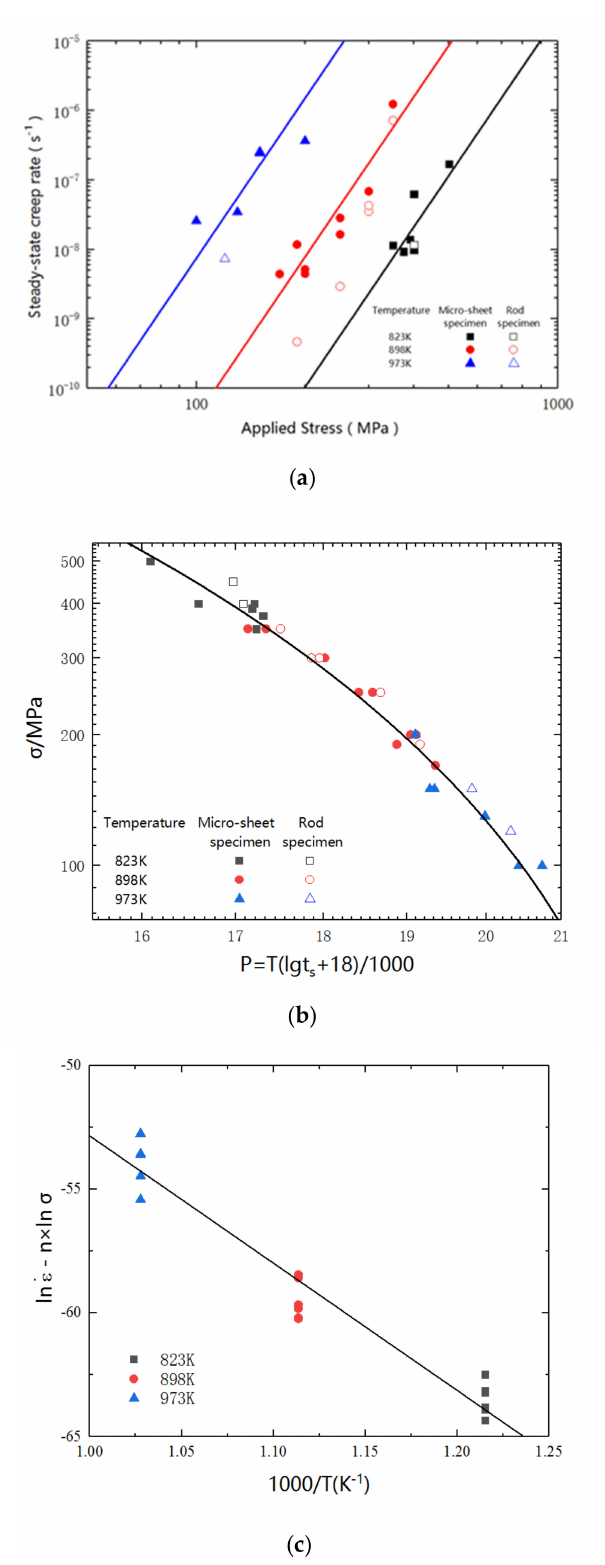
Figure 3. Creep data processing: ( a ) summary of stress-steady state creep rate versus applied stress; ( b ) applied stress versus creep life in Larson-Miller expression; and, ( c ) data fitting for the calculation of apparent activation